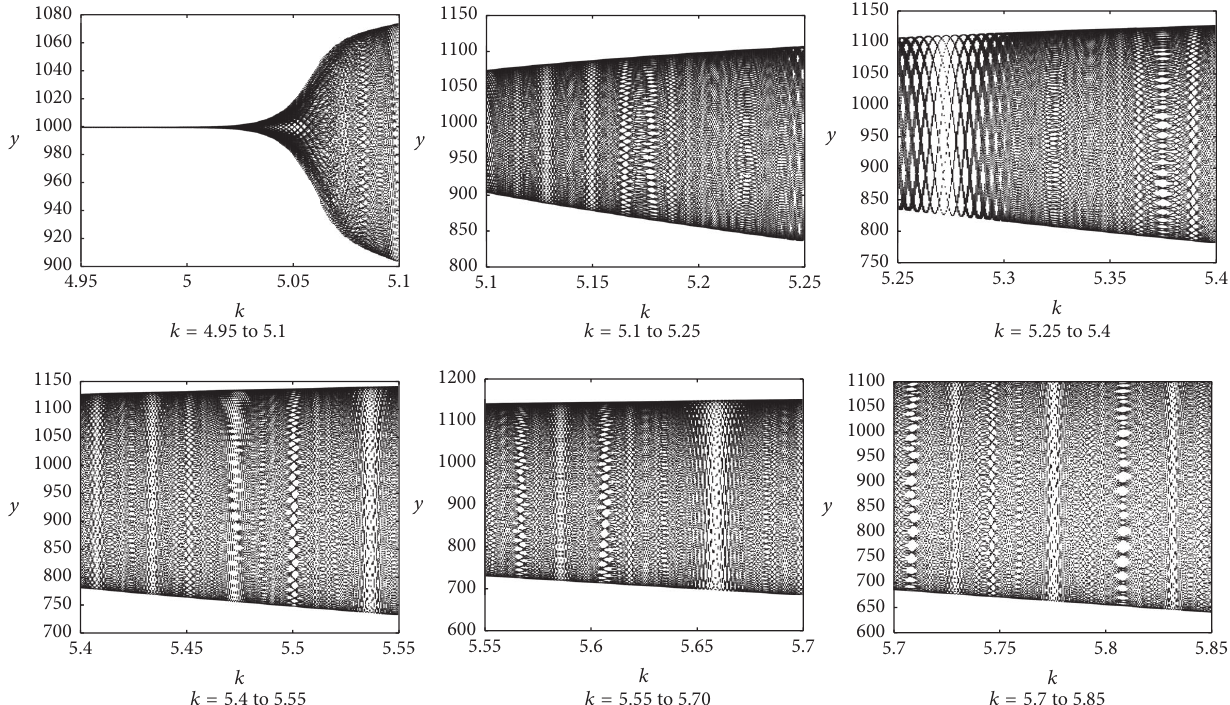
Figure 9: Diagrams of bifurcation of the equilibrium points with respect to 𝑦 for the parameter 𝑘 varying from 4.95 to 5.85, 𝑥 1 = 100.1 , = 1000 for 𝐴 = 1 , 𝑇 = 1000 , 𝛼 = 0.5 , and 𝑠 = 1200 . 𝑦 1